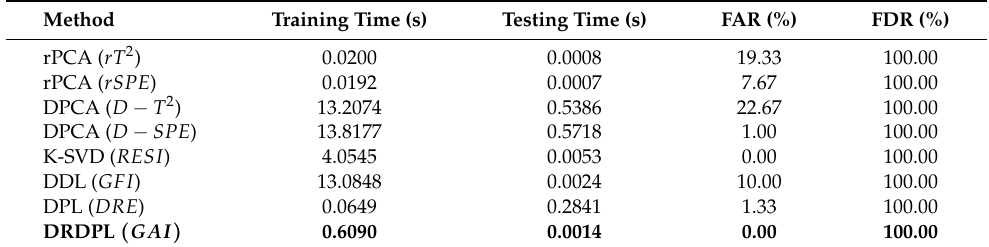
Table 7. The comparison results of anode slippage in aluminum electrolysis process.